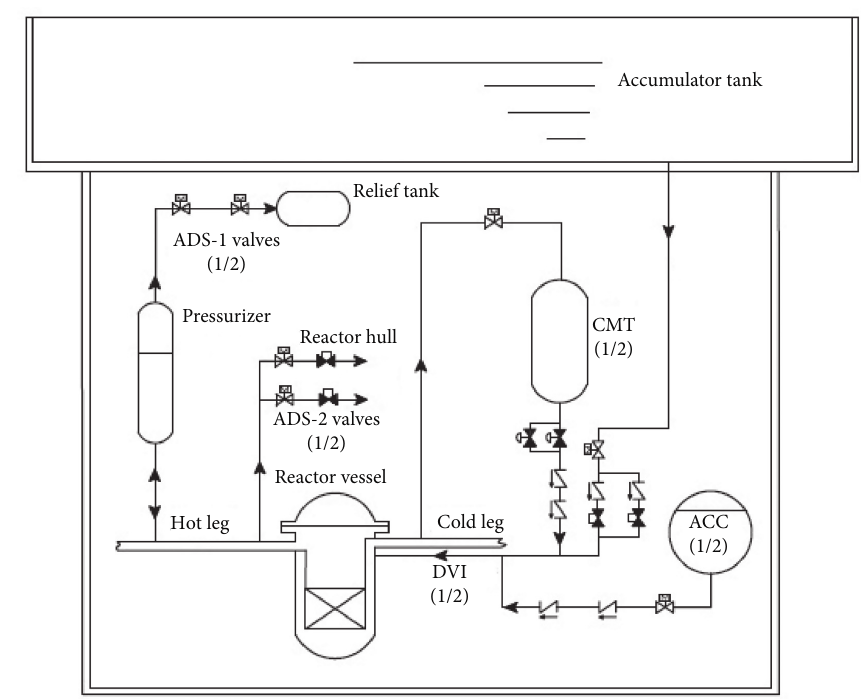
Figure 1: Passive safety injection system configuration.